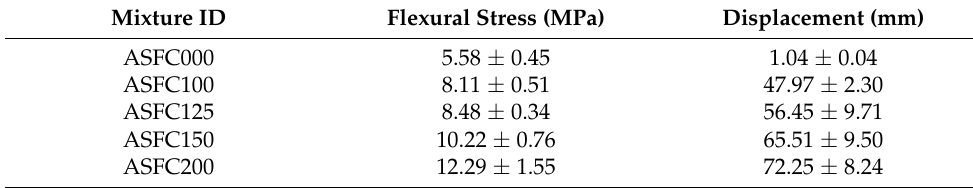
Table 7. Bending test